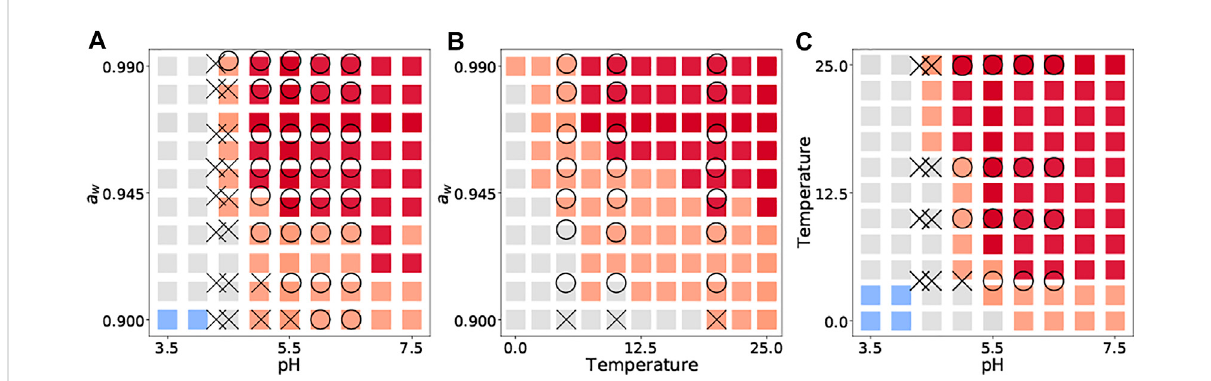
FIGURE 5 Comparison between observed growth ( ○ ) and no-growth ( ☓ ) and predicted change ratio from initial cell counts in a broth of Listeria monocytogenes after 30 days at25 ° C (A) ,with pH5.47 – 5.58 (B) with a w of 0.965 – 0.967 (C) .Experimental data were taken from Koutsoumanis etal. (2004). Each square plot represents the value of the log change ratio ( log N t / N 0 ); dark red is “ strongly increased ” (change > 3-log cycle), red is “ increased ” (change of 2 ± 1 log cycle), grey is “ survival ” (change of 0 ± 1 log cycle), and blue is “ decreased ” (change of − 2 ± 1 log cycle).